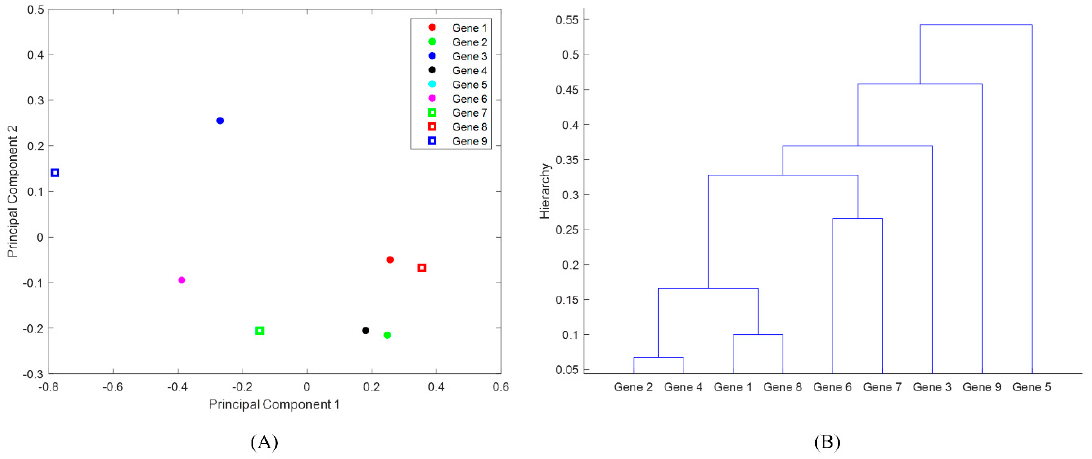
Figure 2. An illustrative example of hierarchical clustering: ( A ) nine genes are projected onto the PC1–PC2 space based on their resistance to antimicrobials azithromycin, cefoxitin, ceftiofur, ceftriaxone, chloramphenicol, ciprofloxacin, gentamicin, kanamycin, nalidixic acid, streptomycin, sulfisoxazole, tetracycline, and trimethoprim-sulfamethoxazole; ( B ) clustering the genes on the basis of their projections in ( A ).